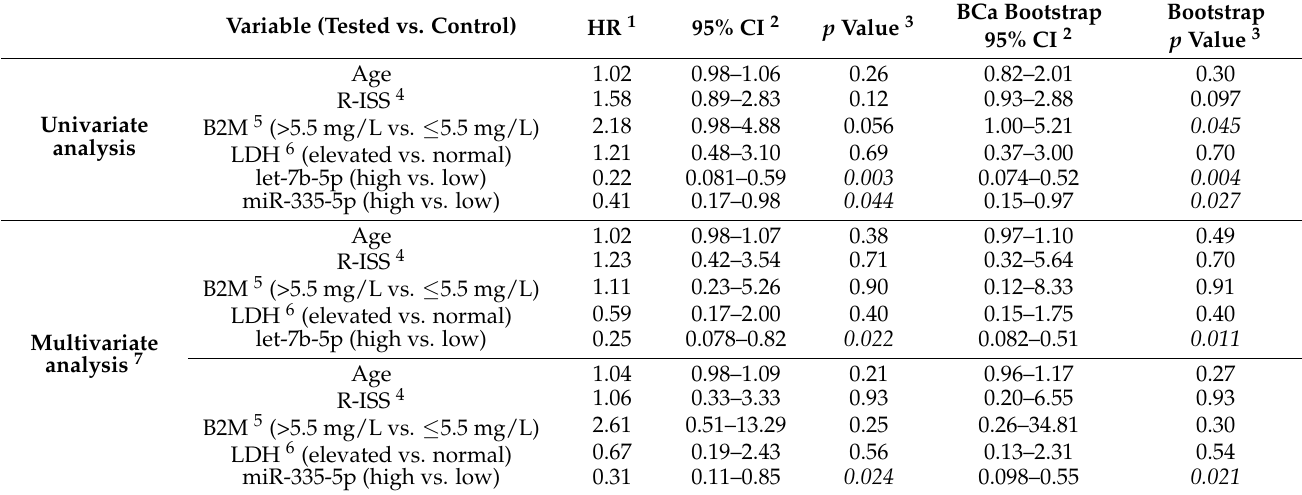
Table 3. Cox regression analysis regarding the prognostic potential of circulating let-7b-5p and miR-335-5p status for the PFS of MM patients.